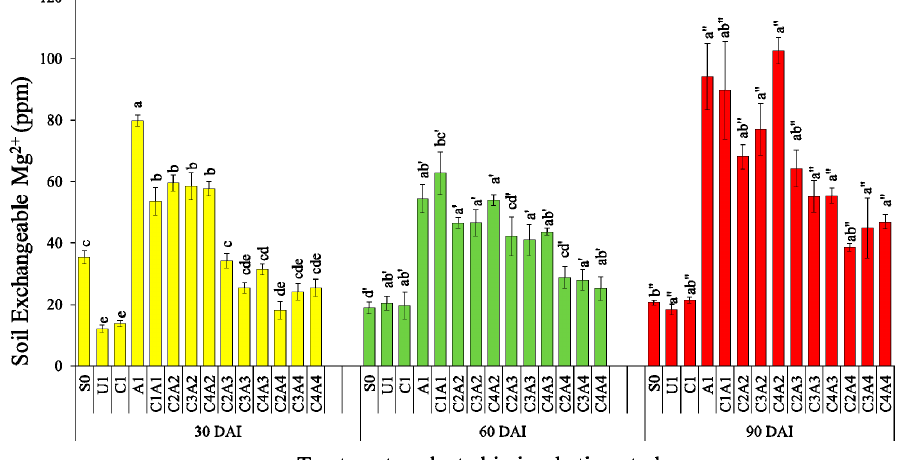
Figure 11. Treatments on soil exchangeable magnesium ions after thirty, sixty, and ninety days of incubation. Means with different letter(s) within the same incubation period indicate significant difference between treatments by Tukey’s HSD test at p ≤ 0.05. Bars represent the mean values ± SE.